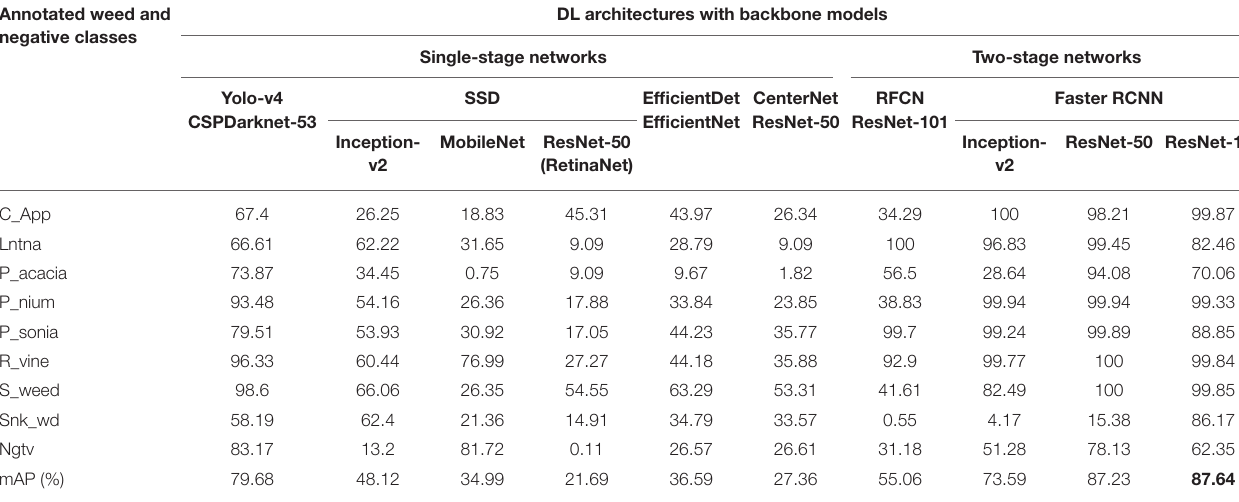
TABLE 3 | Summary of the weed detection results of the DL single-stage and two-stage object detectors in terms of the average precision (in %) of each class. Annotated weed and negative